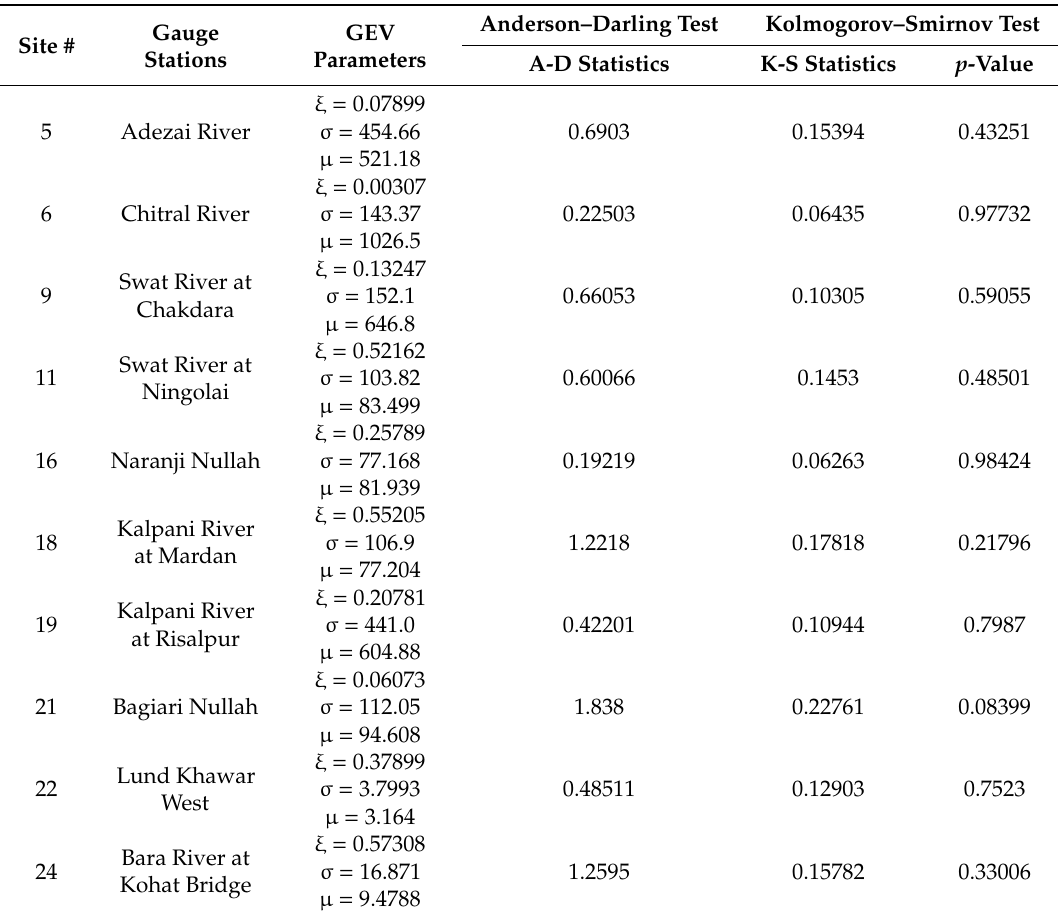
Table 3. The goodness of fit statistics of annual maximum daily peak flow to generalized extreme value (GEV) distribution.